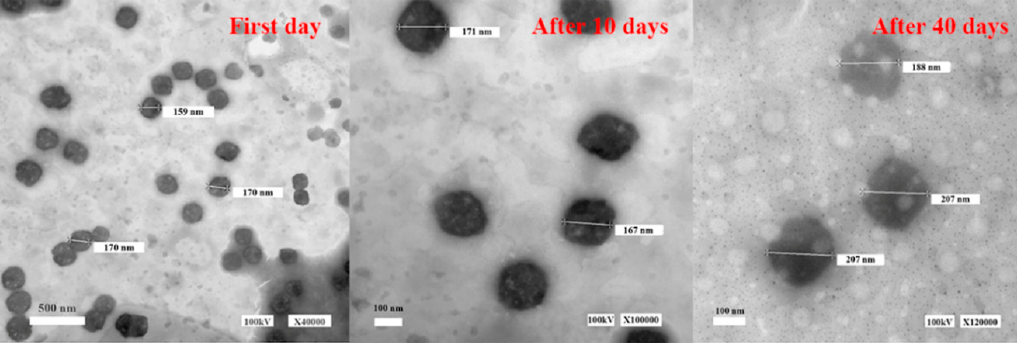
Figure 3. Morphology of vesicles under TEM.